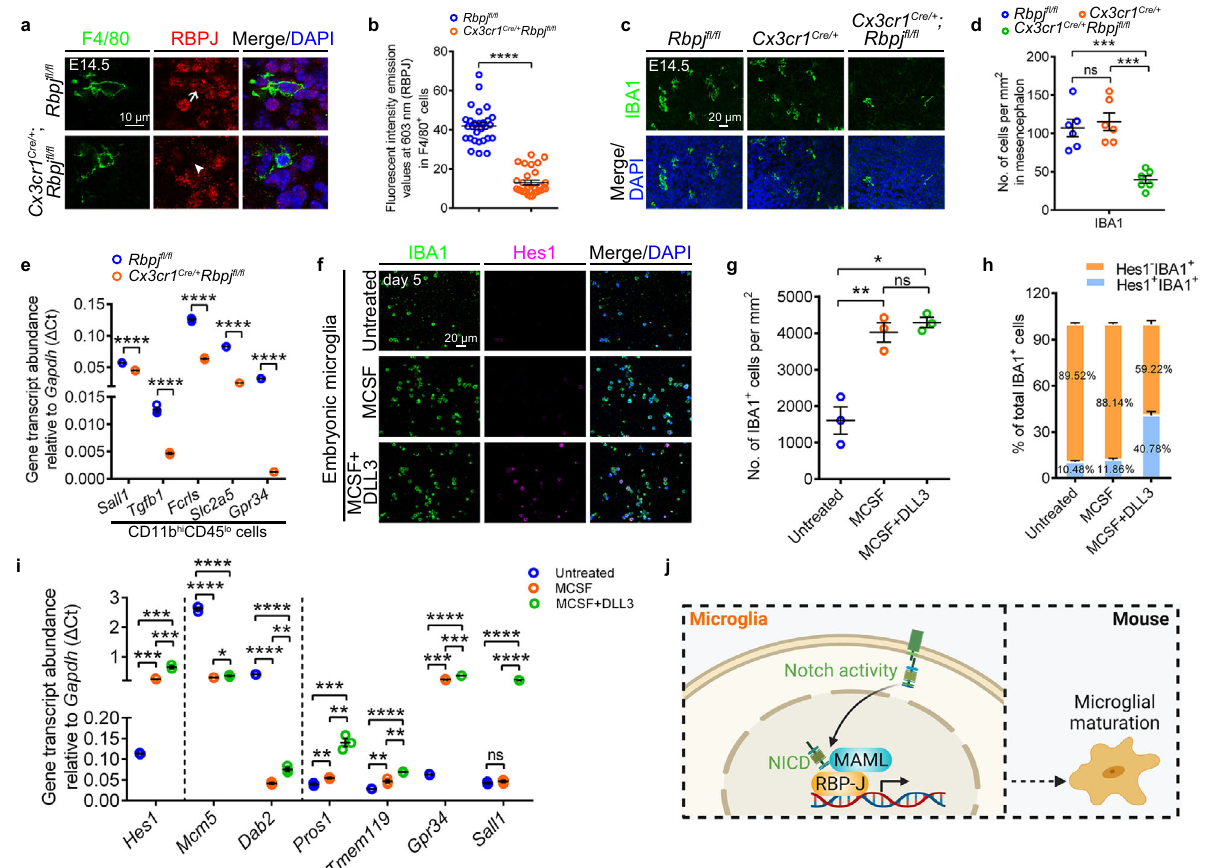
Fig. 8 | Notch activity promotes microglial development in vivo and in vitro. a , b Immuno fl uorescence ( a ) and fl uorescent intensity emission values ( b ) of RBPJ (red) in F4/80 + (green) cells in the sagittal sections of E14.5 Rbpj fl / fl and Cx3cr1 cre/+ Rbpj fl / fl mice ( n =3 mice in each group). Each dot in ( b ) denotes one cell. Ten cells per mouse were quanti fi ed. The white arrow indicates the co-localized signals of RBPJ and F4/80, whereas white arrowhead point to the limited signals of RBPJ. c , d Immuno fl uorescence ( c ) and quanti fi ed cell density ( d ) of IBA1 + cells in the sagittal sections of E14.5 Rbpj fl / fl , Cx3cr1 cre/+ and Cx3cr1 cre/+ Rbpj fl / fl mice ( n =6 mice in eachgroup).Eachdotdenotesonemouse.Threeslicespermousewerequanti fi ed. e Transcriptionallevelsof Sall1 , Tgfb1 , Fcrls , Slc2a5 ,and Gpr34 inCD11b hi CD45 lo cells from E14.5 Rbpj fl / fl and Cx3cr1 cre/+ Rbpj fl / fl mice mesencephalon. The data are from three independent experiments. Each dot represents an independent experiment. f Immuno fl uorescence of IBA1 and Hes1 in the embryonic microglia in vitro